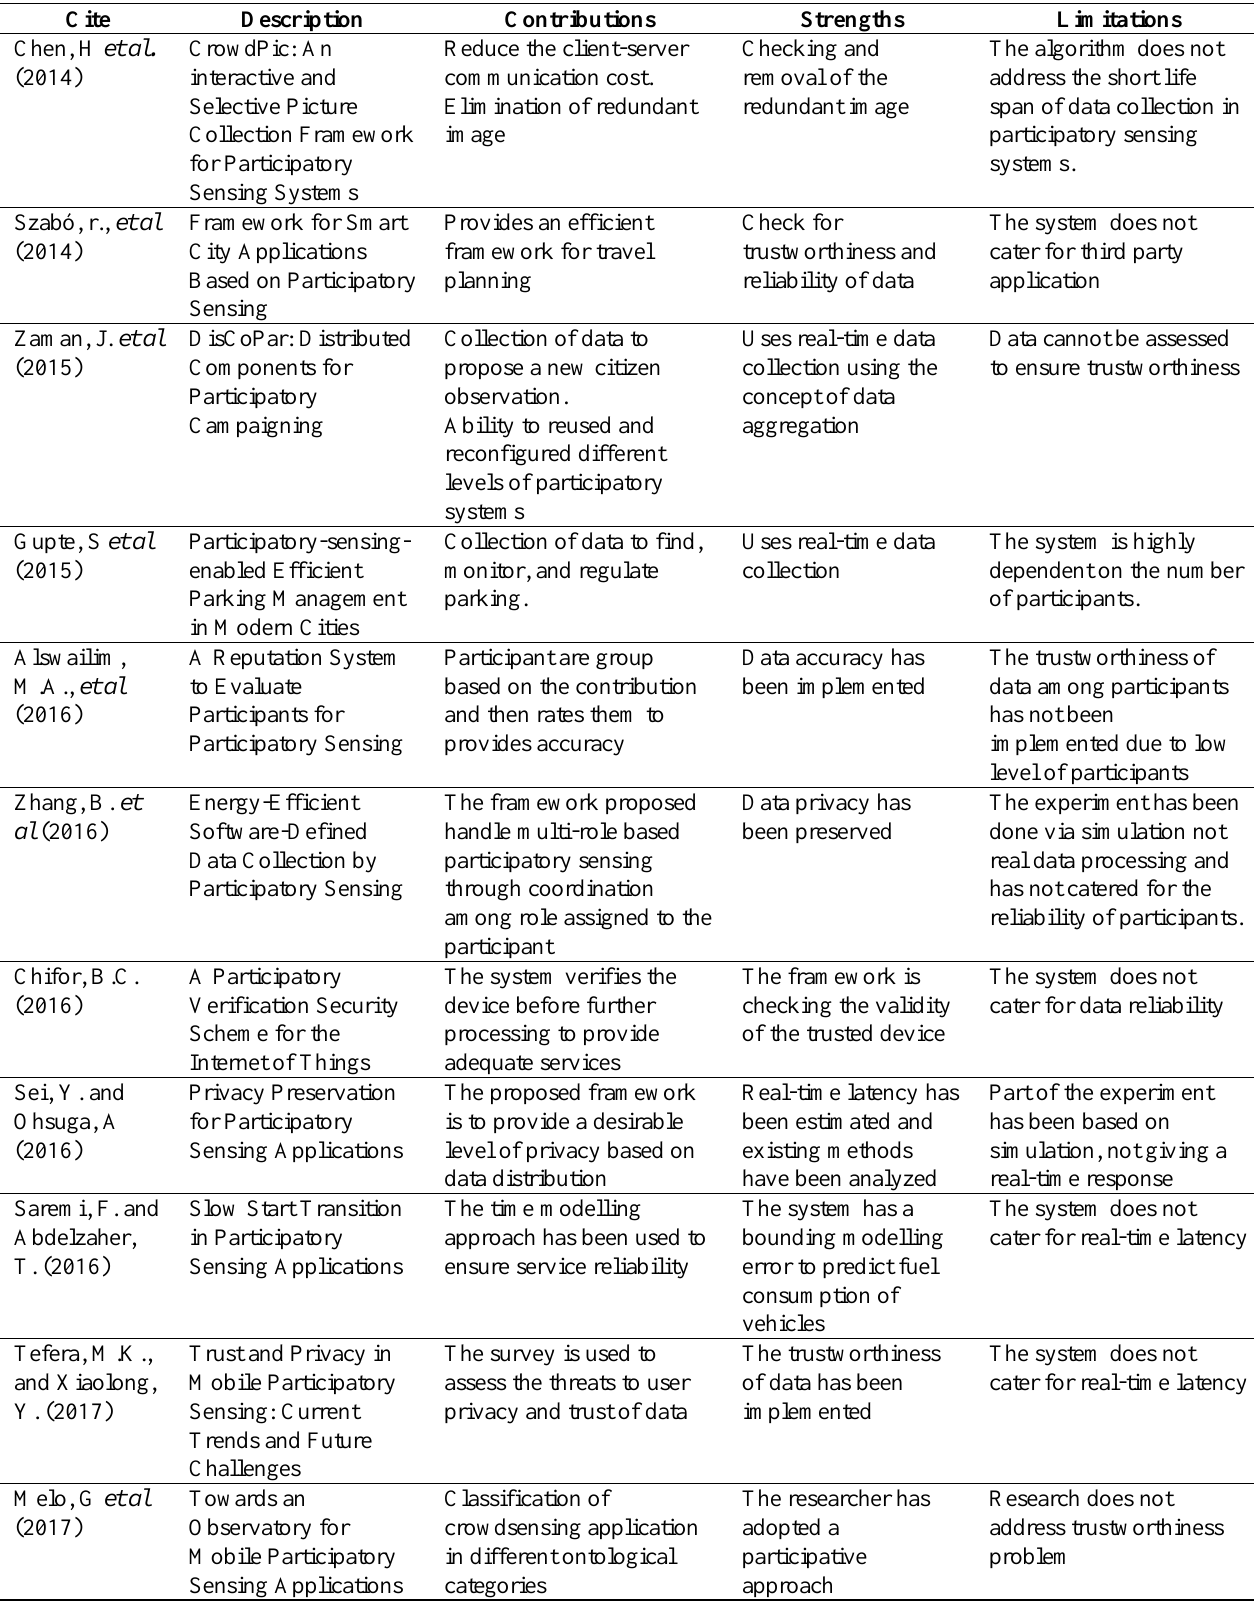
Table 2. Environmental Participatory Sensing